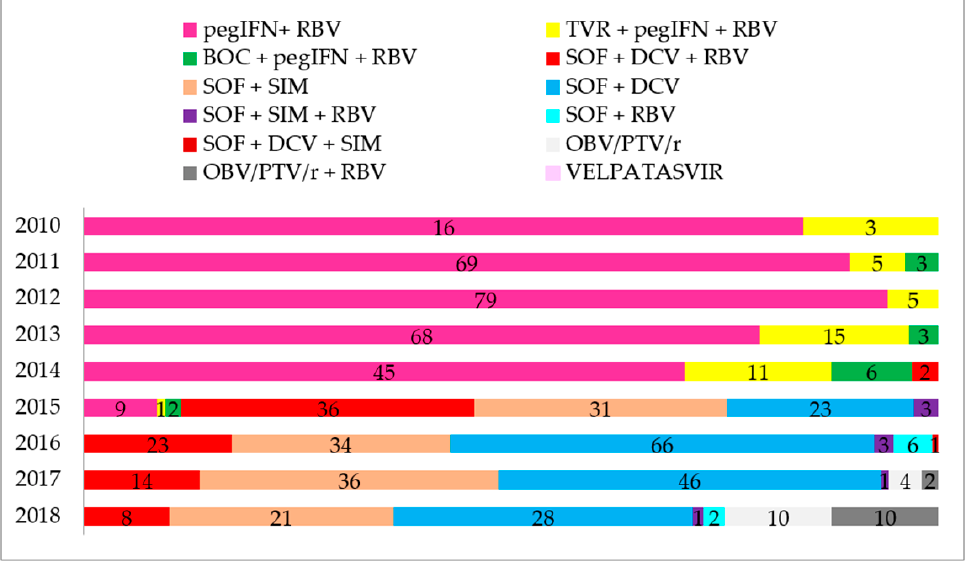
all patients treated in RH